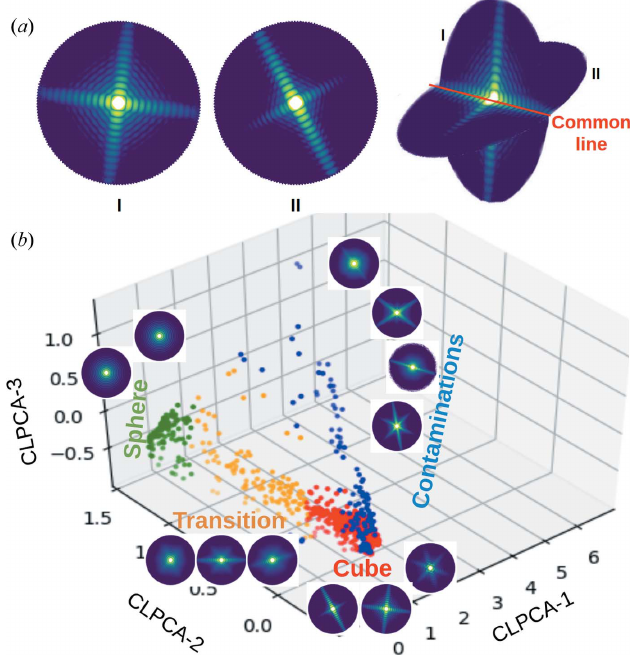
Figure 2 ( a ) An illustration of the common line between two patterns of similar- shaped objects but with different orientations. ( b ) The distribution of 1000 averages in the 3D CLPCA space. Different colours are manually divided groups from the first two components: contaminants (blue), cubes (red), transition (yellow) and spheres (green). Typical patterns for averages in each group are also shown on a logarithmic